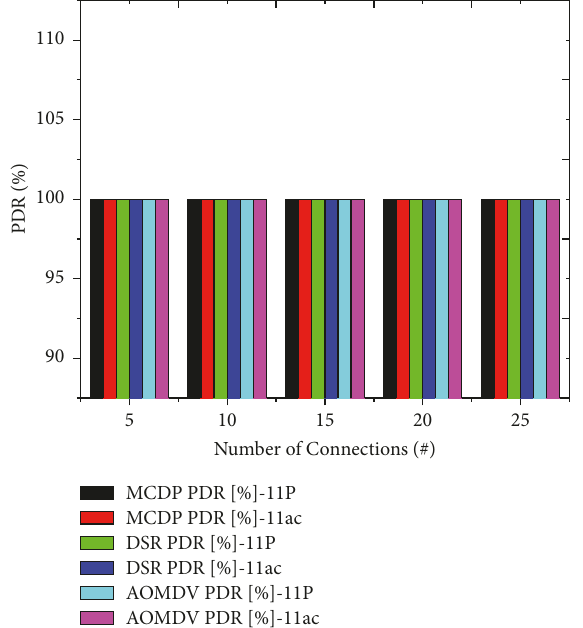
Figure10:PDRcomparisonofMCDP,DSR,andAOMDVprotocols over 802.11P and 802.11ac with different numbers of connections.